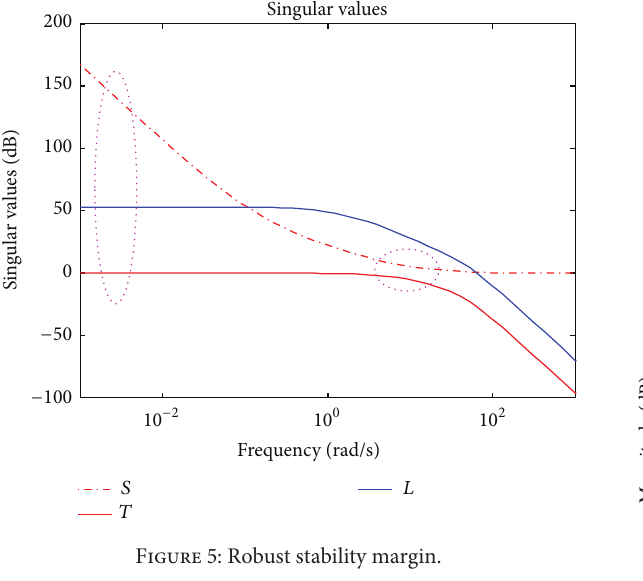
Figure 8: DOB-based LQG controller.